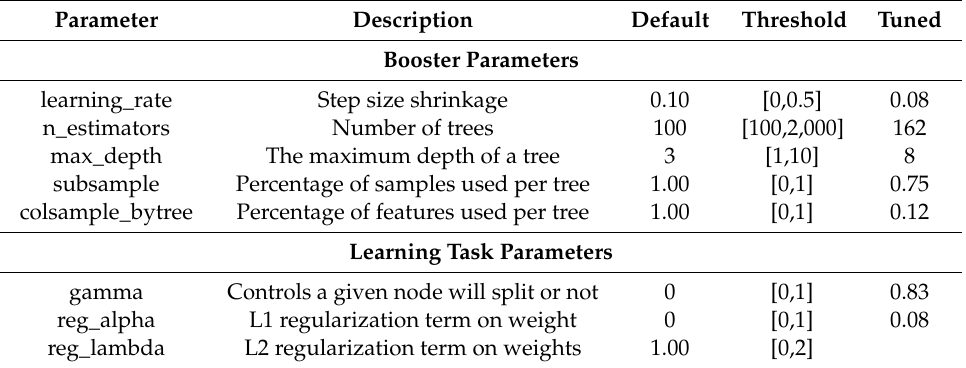
Table 1. Information about the parameters of XGBoost tuning by multi-objective particle swarm optimization (MOPSO) in this work: name, description, default value, threshold while searching, and tuned